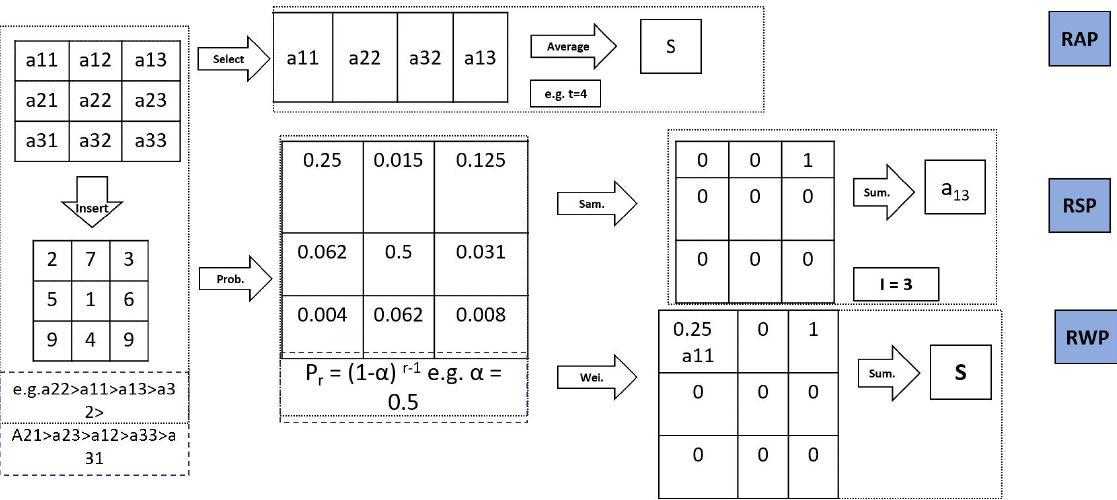
Figure 7. Rank-based average pooling: rankings are presented in ascending order, and activations for a pooling area are listed in descending order. The pooling output is calculated by averaging the four largest activations, since t = 4.